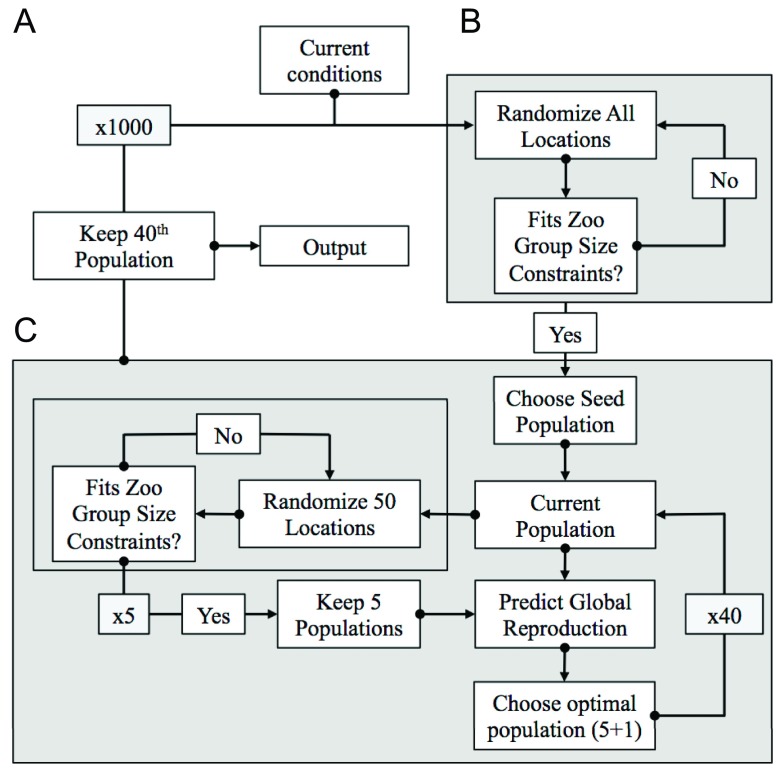
Map of the genetic/packing algorithm used to optimize the social group structure.(
A) We generated 1000 seed populations that satisfied group size constraints for all zoos, with individuals randomly assigned to locations. (
B) A local optimization algorithm was applied to each seed population. This algorithm generated “mutated” populations that randomly reassigned new locations to groups of 50 individuals from the seed population, rejecting populations that did not satisfy group size constraints, to generate five new populations. We forecast the overall reproductive success for these five “mutated” populations and the original population, and selected the global optimum of all six populations. (
C) The globally optimal population was then used to start the next cycle of mutation-selection, and the total process repeated 40 times.